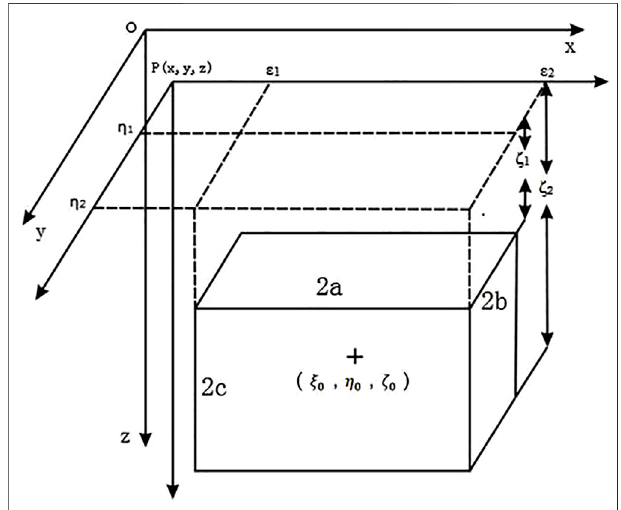
FIGURE 1 | Schematic of the coordinate conversion and forward model of the vertical